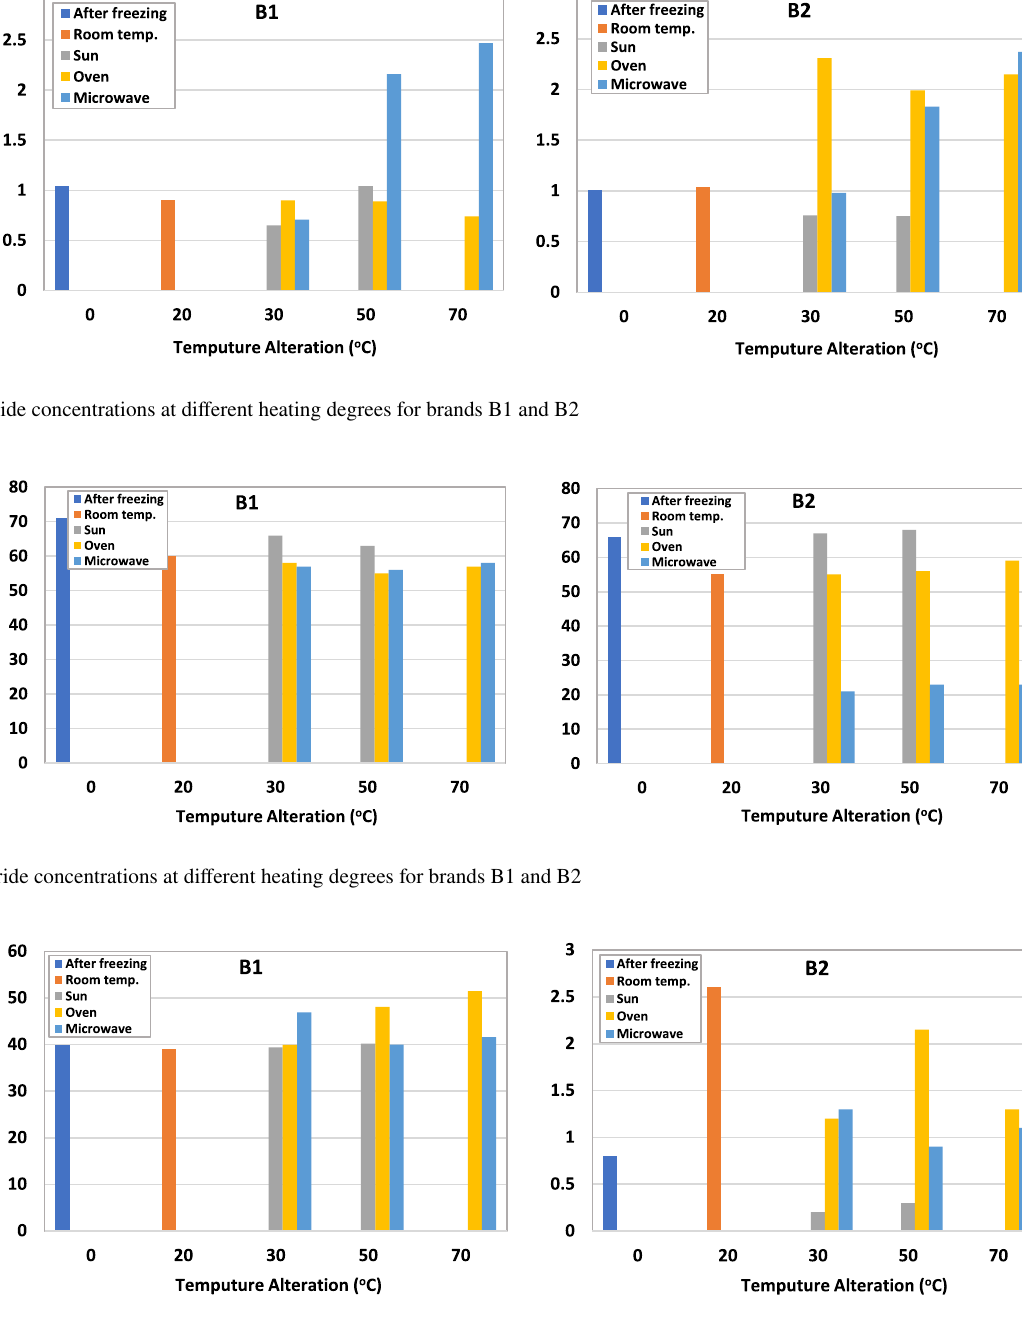
Fig. 6 Sodium concentrations at different heating degrees for brands B1 and